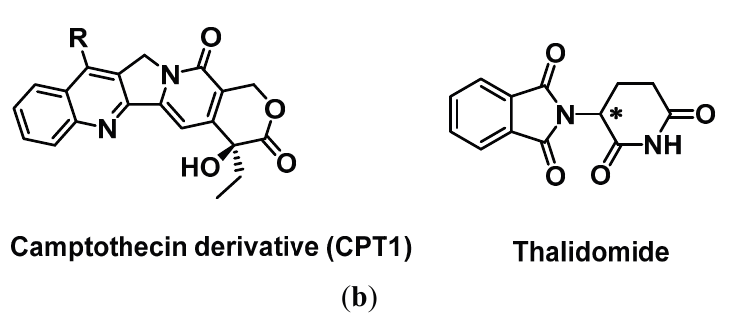
Figure 4. ( a ) Chemical structures of some base-modified dN*TPs used in aptamer selection experiments; ( b ) Target molecules camptothecin and